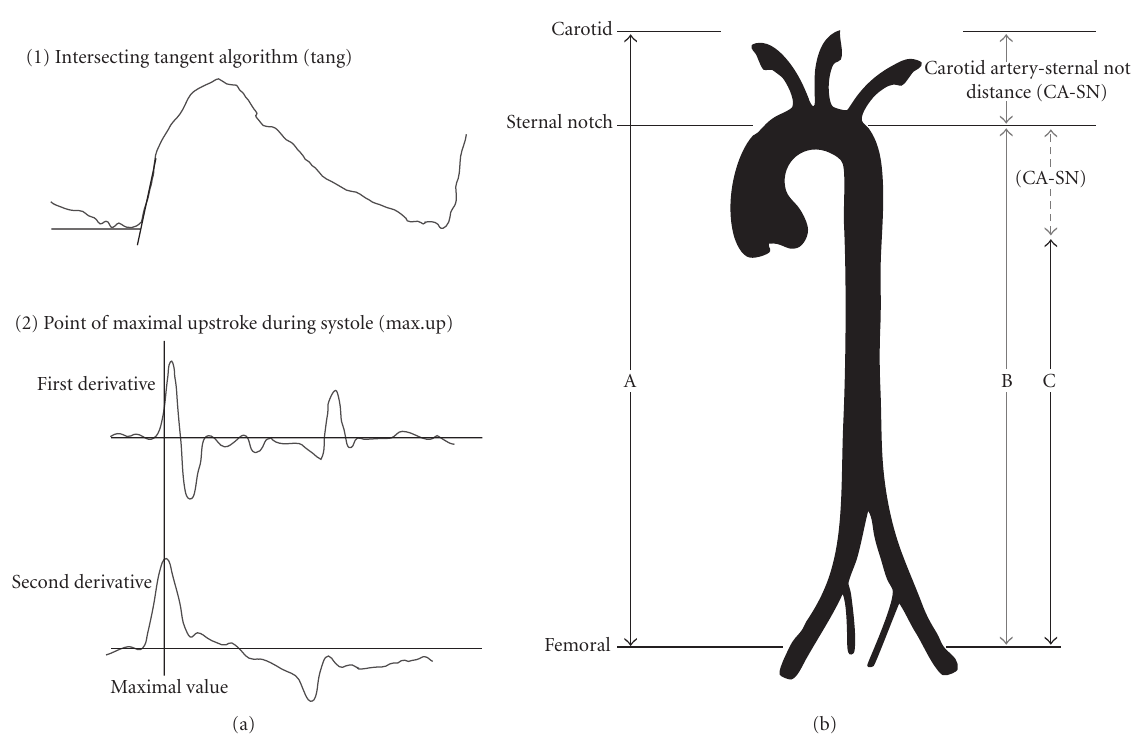
Figure 1: (a) Algorithms employed to determine the carotid-femoral pulse transit time (PTT): intersecting tangent algorithm (tang) and maximal upstroke during systole (max.up). (b) Distances employed to determine the carotid-femoral PWV. Distance A: direct distance between the carotid and femoral region (direct). Distance B: distance between the sternal notch and the femoral region (sn-fem). Distance C: subtracted distance, obtained as B minus the carotid to sternal notch distance (subtracted). Combing the two PTT algorithms and the three distances, six PWV were quantified: PWV direct / tang , PWV direct / max . up , PWV sn-fem / tang , PWV sn-fem / max . up , PWV subtracted / tang , and PWV subtracted / max . up . In addition the real PWV was calculated (see